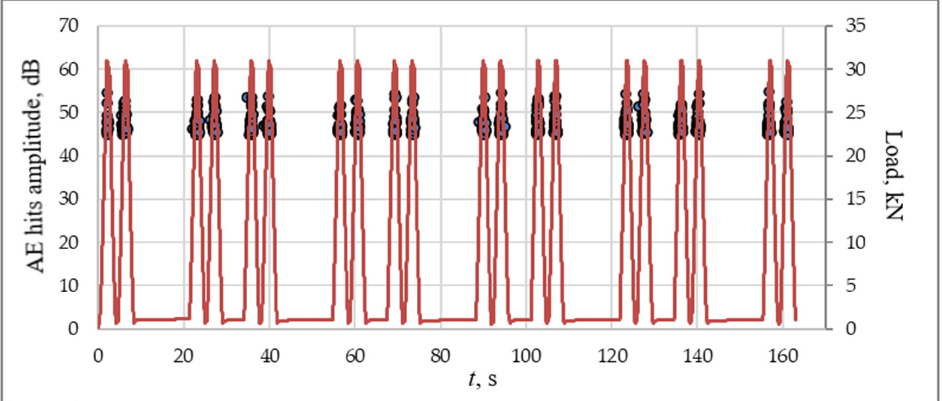
Figure 4. Dependence of AE hits amplitudes on time (blue) and dependence of loading force on time (red) for defect-free specimen.